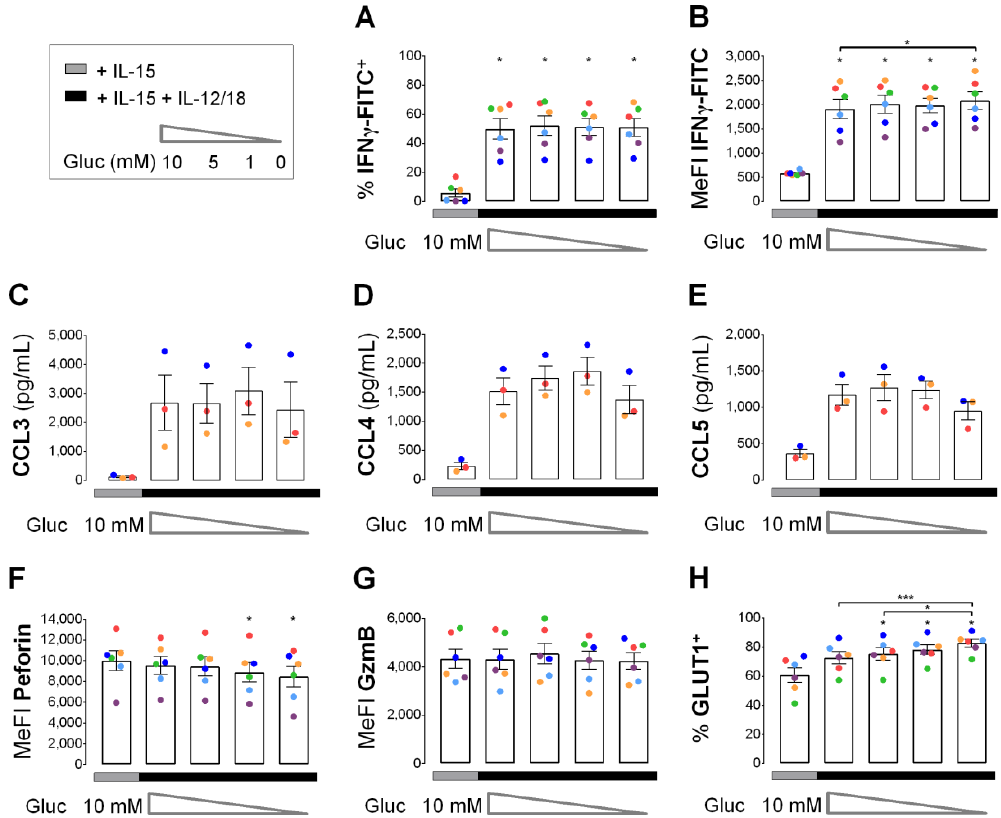
Figure 7. Early cytokine responses in IL-15 primed human NK cells in response to IL-12/IL-18 do not require glucose. NK cells from 3 or 6 bu ff y coats were cultured for 16 h and primed with IL-15